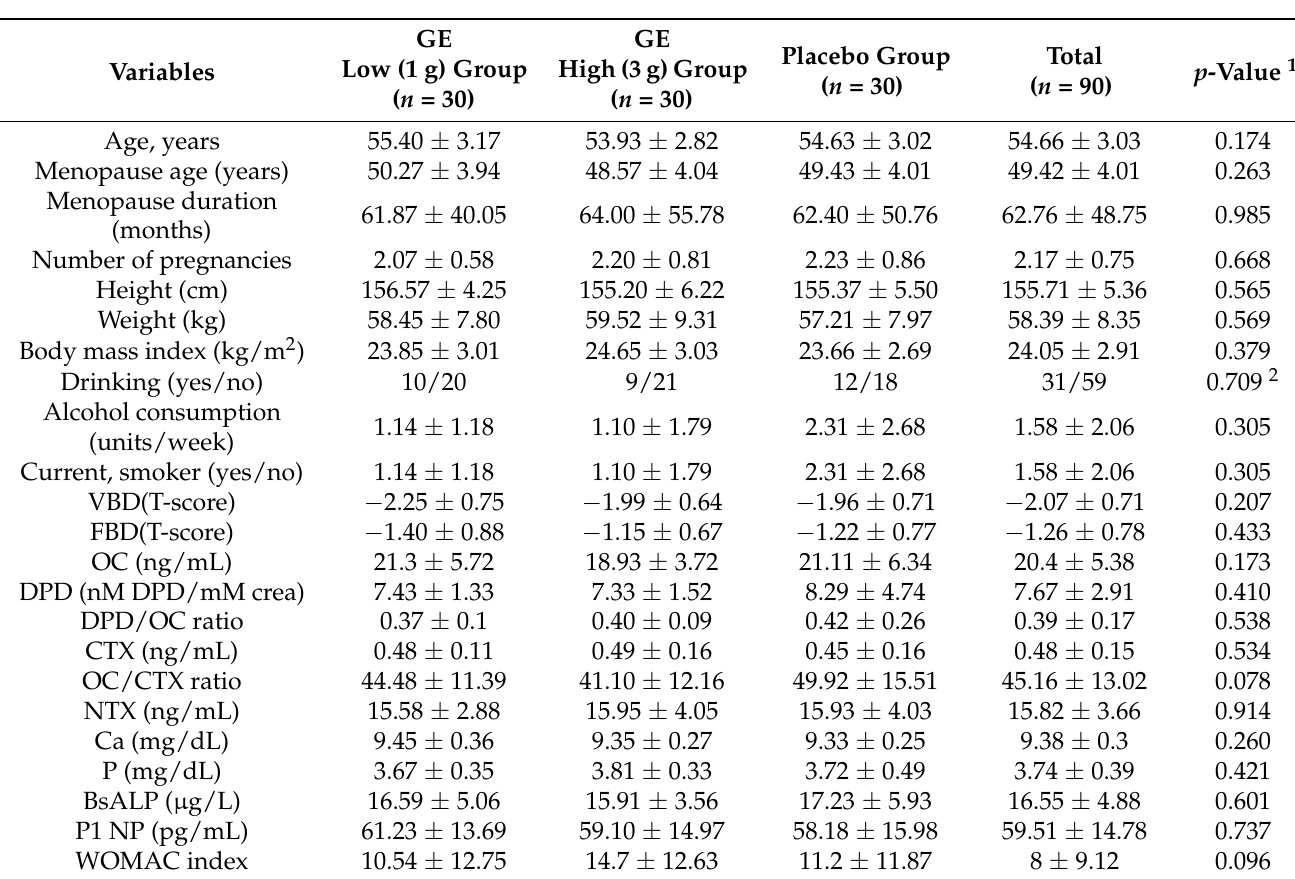
Table 2. Demographic characteristics of the study